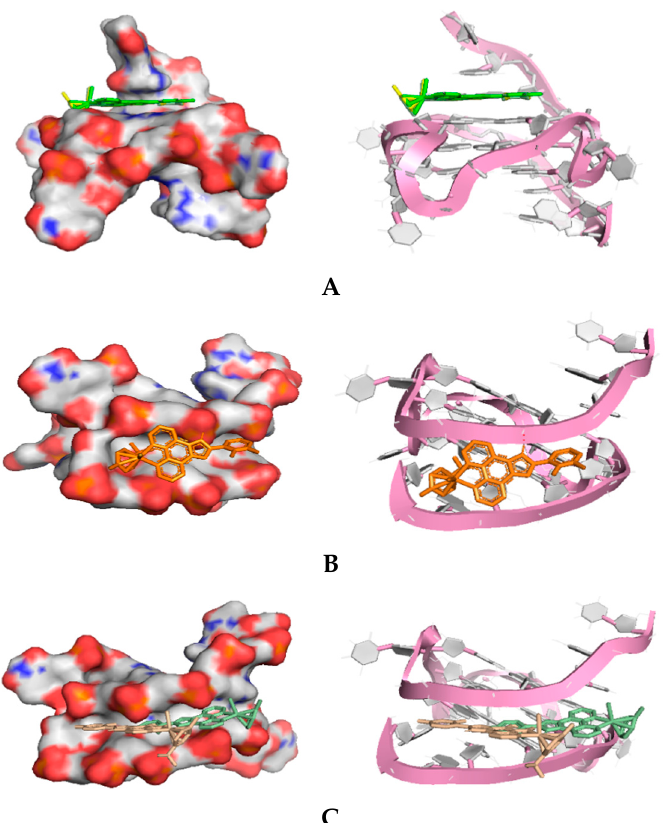
Figure 1. Binding mode and site of the arene Ru(II) complexes that interacted with c-myc G-quad- ruplex DNA analyzed by molecular docking. Left (G-quadruplex is rendered with the hydrophobic surface of molecular structure), Right (G-quartets are displayed in a stick mode) ( A ) 1 (green), 2 (yellow) and 4 (cyan); ( B ) 3 (orange); ( C ) 5 (pale green) and 6 (wheat).